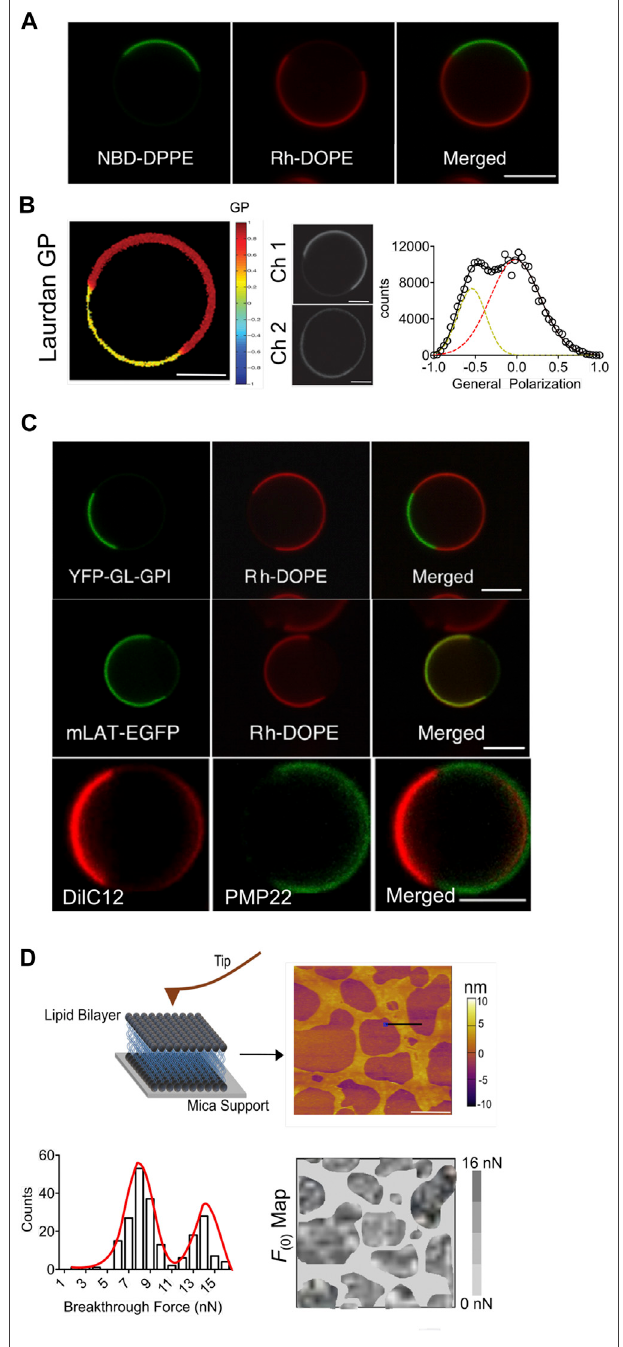
Schematic representation of atomic force microscopy and spectroscopy work fl owforstudyingmechanicalmembraneproperties.Left,solidsupported bilayer (SSB) formed from GPMVs fusion on solid mica support. Topo- FIGURE 4 | Giant plasma membrane vesicles for investigating graphical AFM image of such a SSB and the corresponding force maps, membrane organization and proteins localization. (A) Fluorescent images depicting breakthrough force distribution across bilayer surface. AFM Image showing phase segregation into liquid ordered (l o ) and liquid disordered (l d ) reprinted from Biopyhiscal Journal, Adhyapak, P. et al . Dynamical Organi- regions in cell-derived GPMVs labeled with NDB-DPPE (green, zation of Compositionally Distinct Inner and Outer Membrane Lipids of preferentially partitions into l o ) and Rh-DOPE (red, partitions into l d ), scale bar: Mycobacteria, 2020, 118, 1,279 – 1,291. Copyright (2020), with permission 5 μ m. Image reprinted from Biochimica et Biophysica Acta (BBA), from Elsevier. Breakthrough force corresponds to force required to pierce Biomembranes, Sengupta, P et al. Structural determinants for partitioning of through the bilayer surface. Histogram depiction of the breakthrough force lipidsandproteinsbetweencoexisting fl uidphasesingiantplasmamembrane distribution showing bimodal force distribution indicative of at least two vesicles, 2008, 1778, 20 – 32. Copyright (2008), with permission from mechanically distinct lipid ( Continued )